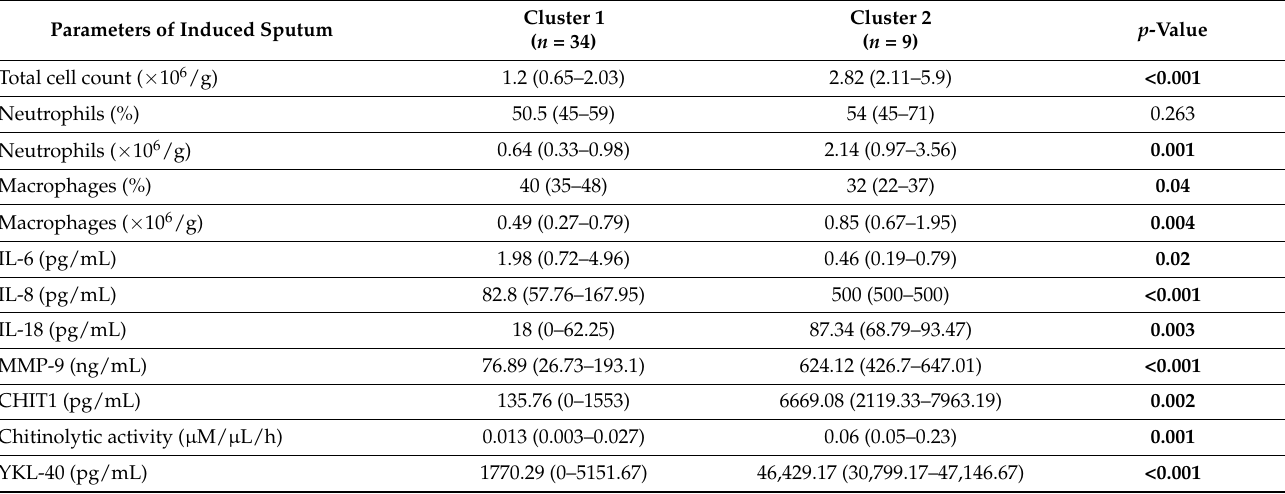
Table 5. Cellular characteristics and the levels of sputum mediators in the two main identified clusters.